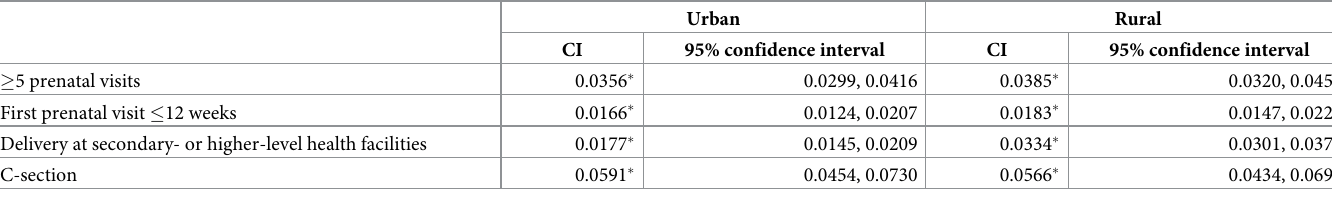
Table 3. The concentration index for maternal health services utilization by urban and rural